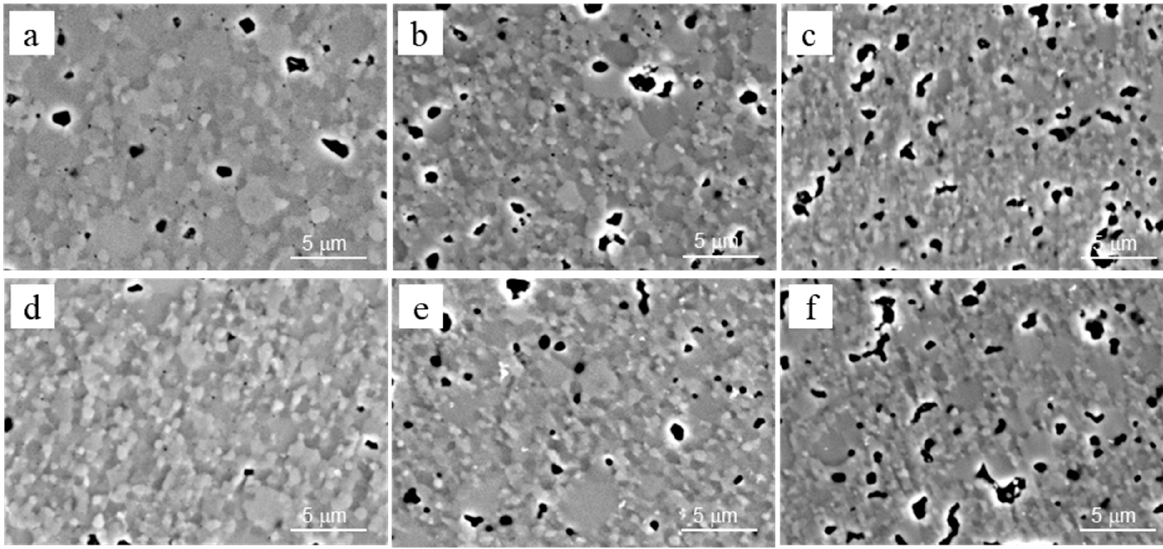
Figure 3. SEM-SE microstructure of ( a – c ) 3YSZ and ( d – f ) 6YSZ ceramics sintered at ( a , d ) 1550, ( b , e ) 1500, and ( c , f ) 1450 °C.